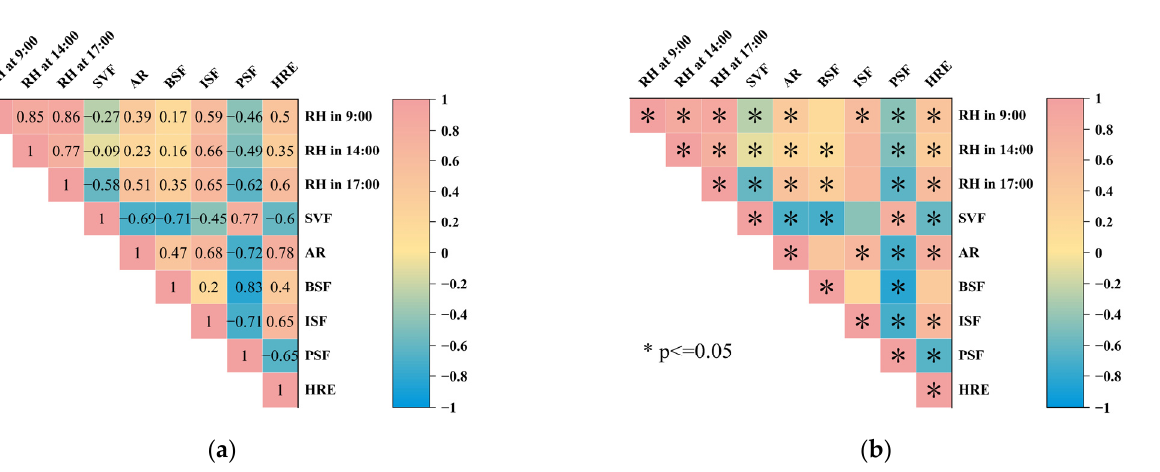
Figure 9. Correlations between air temperature at specific times and spatial morphology character- istic parameters among the whole campus. ( a ) Heat map of correlation coefficient. ( b ) Heat map of significance.